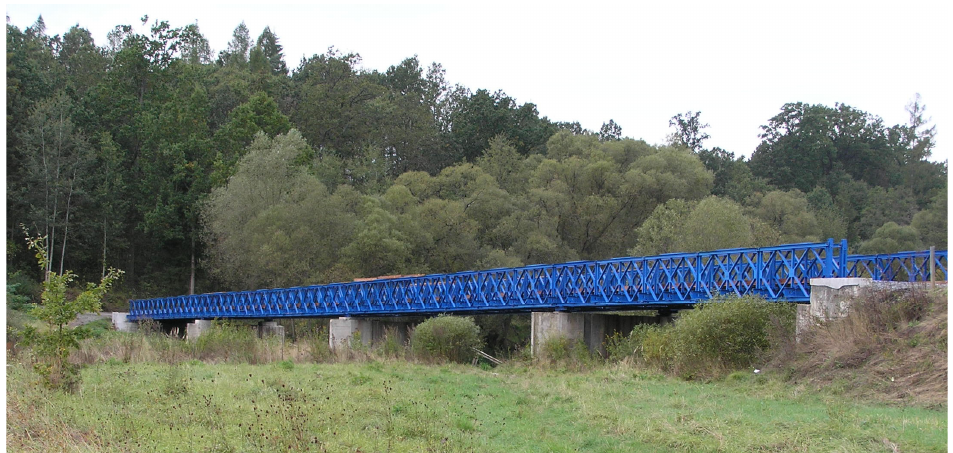
Figure 3. ‘Long ‐ term’ temporary bridge Bailey bridge (DS ‐ 15 + 21 + 27 + 21) over Lužnice river (Czech Republic).